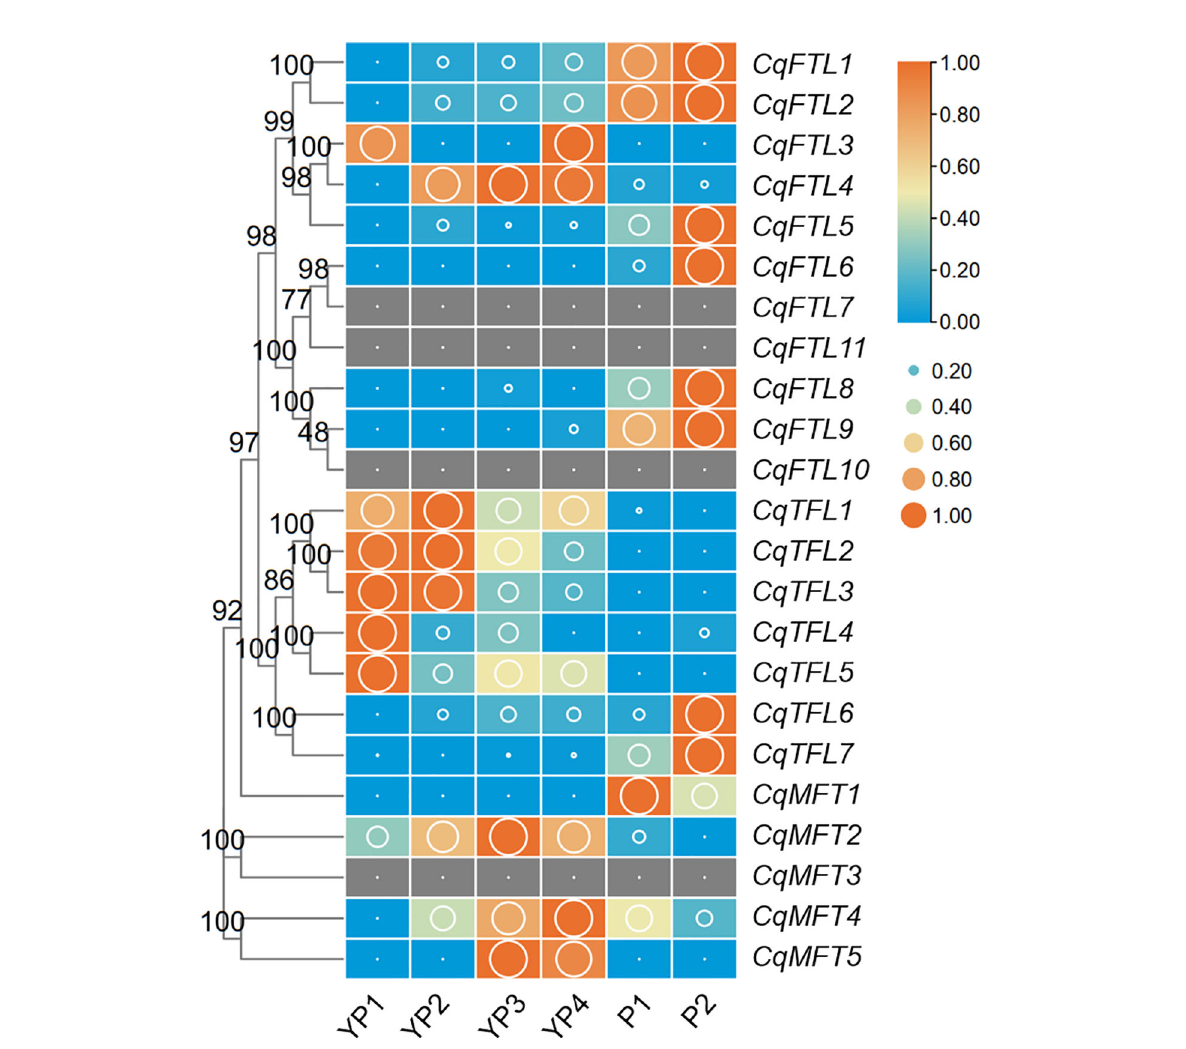
FIGURE 8 Expression of PEBP genes during quinoa in fl orescence development. RNA-seq data of in fl orescences sampled from 6 developmental stages was used to investigate the expression changes of PEBP s (Wu et al., 2019). Expression levels are denoted by FPKM values (cutoff=0.1). YP1 to YP4 indicates non-branching young panicles at 4 earlier developmental stages. P1 and P2 indicate branching panicles at 2 later developmental stages. Each expression value was generated from three replicates. Orange boxes with larger-size bubbles indicate higher expression levels. Expression levels at 6 stages of the same gene were normalized to 0 to 1 by